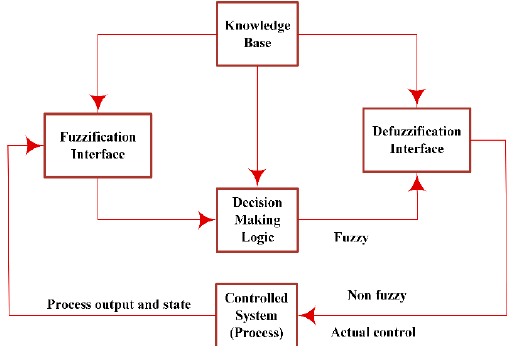
Figure 7. FLC design structure. Table 1. Parameters of Maglev.